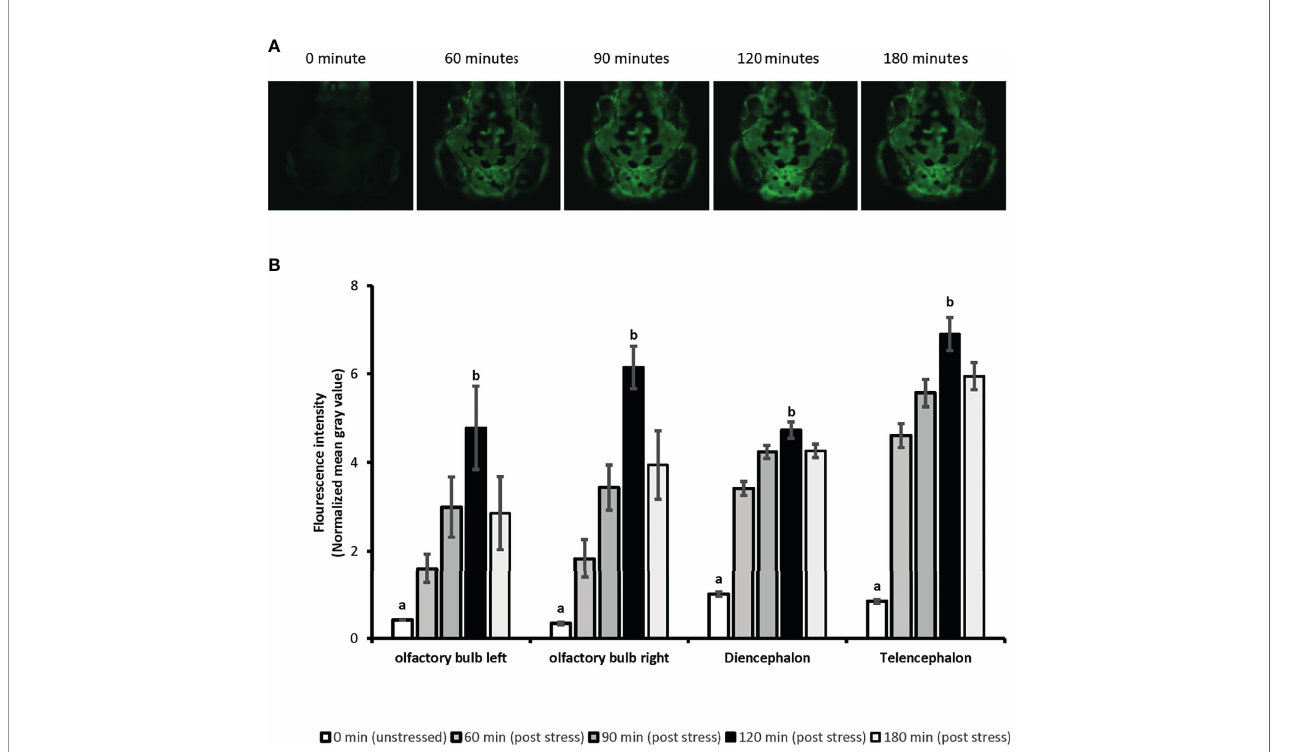
FIGURE 1 | The time-lapse fl uorescence imaging captures the ubiquitous eGFP expression in 4dpf SR4G transgenic zebra fi sh line following the handling stress. Panel (A) shows the direct fl uorescent imaging of 4dpf SR4G transgenic larva head at fi ve different time-points after the handling stress. Panel (B) shows the quanti fi ed fl uorescence intensity (mean grey value) after the handling stress in four different anatomical regions; diencephalon, telencephalon, left olfactory bulb and right olfactory bulb at fi ve different time-points. Means (± SEM) marked with different letters (a, b) are signi fi cantly different within each anatomical position; p < 0.01;